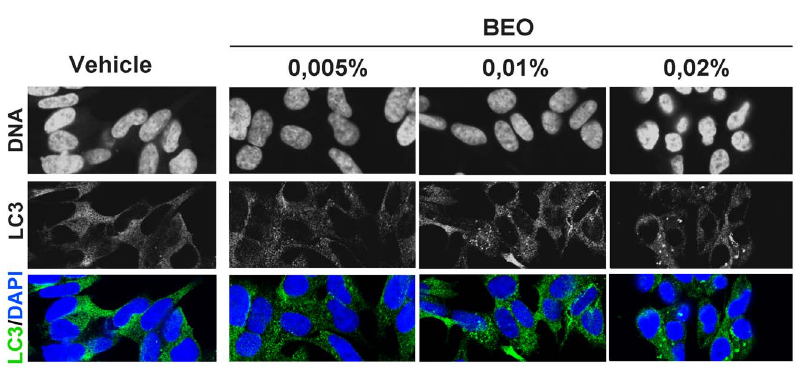
Figure 3. Accumulation of endogenous LC3 positive structures in cells exposed to increasing concentrations of BEO. SH-SY5Y cells were exposed to vehicle (ethanol 0.018%) or BEO (0.005–0.02%) for 30 minutes and immunostained with anti-LC3 antibody; nuclei were counterstained with DAPI. Confocal analysis of endogenous LC3 intracellular distribution shows a dose-dependent increase of LC3 puncta (autophagosomes) in cells treated with BEO 0.01% and 0.02% as compared to vehicle or BEO 0.005% treated cells. The described patter of LC3 distribution was observed in three independent